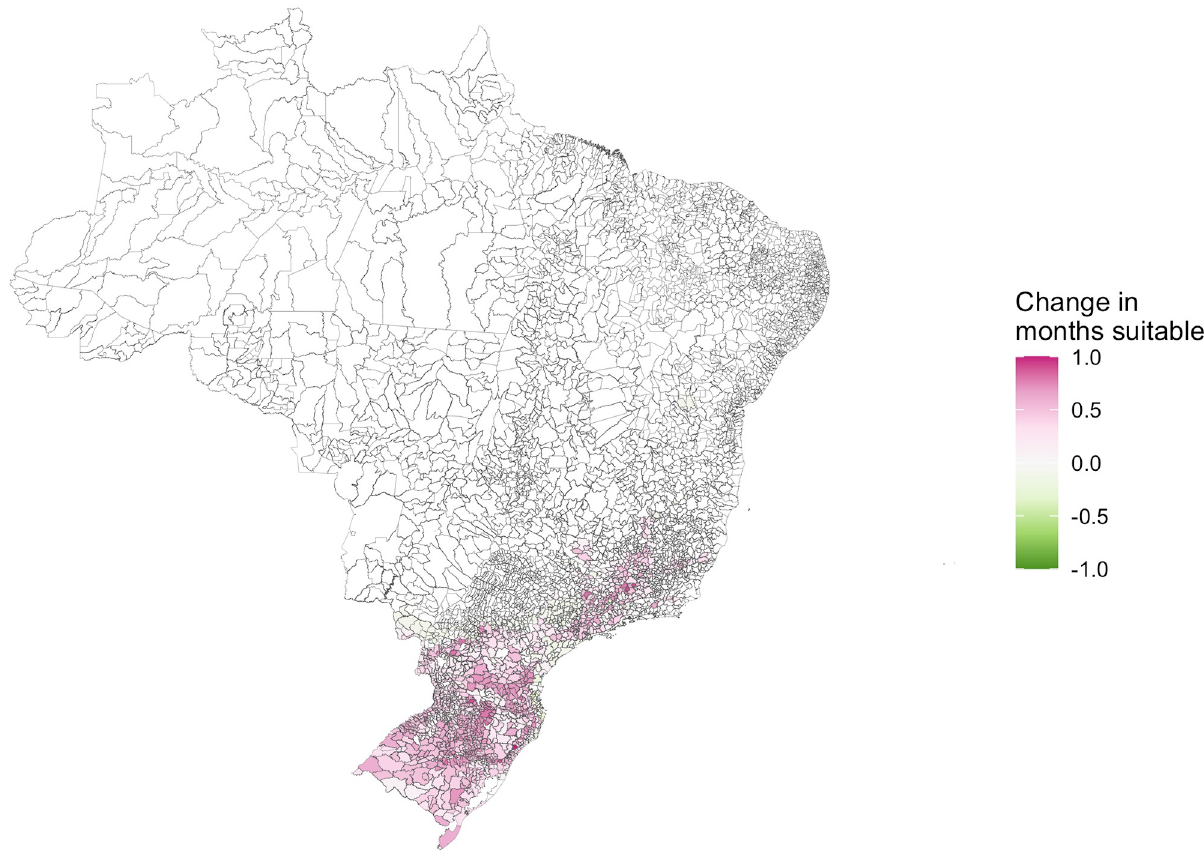
Fig 1. The difference between the average number of months with suitable temperatures for dengue transmission in 2001–2010 and 2011–2020. The number of months with temperatures between 16.2˚C and 34.5˚C has increased on average (shown in pink) in parts of South and Southeast Brazil which were previously considered ‘protected’ from dengue transmission. Maps were produced in R using the geobr package [32,35] (https://ipeagit. github.io/geobr/).